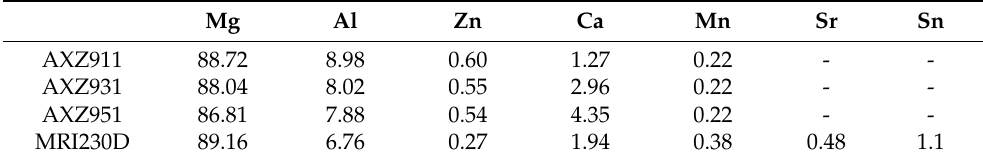
Table 1. Chemical composition in wt.% of the investigated alloys. Mg Al Zn Ca Mn Sr